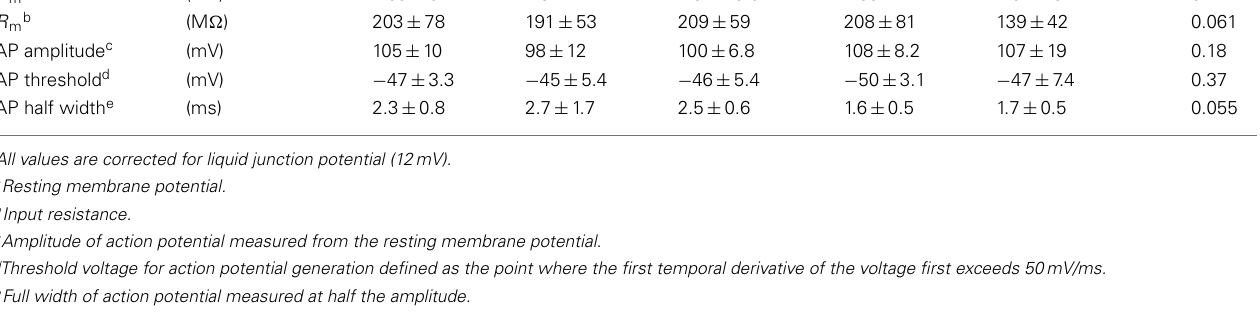
Table 2 | Responses of GECIs in cortical layer 2/3 pyramidal cells.